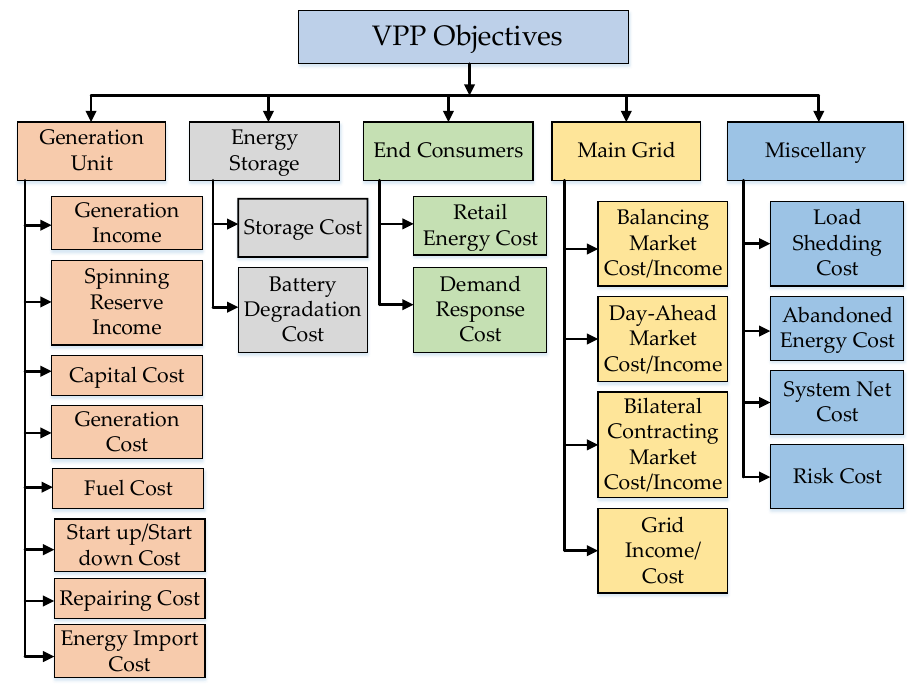
Figure 5. A classification of different optimization objectives of the virtual power plant (VPP).